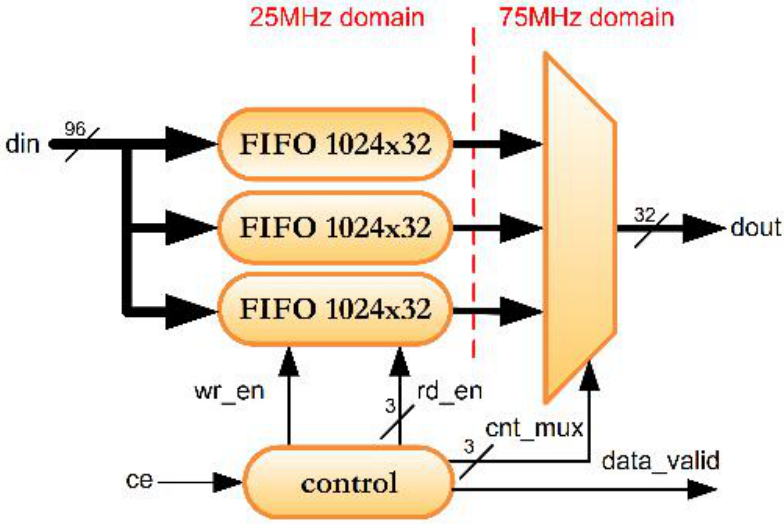
Figure 13. Block diagram of the implemented packer.vhd module.